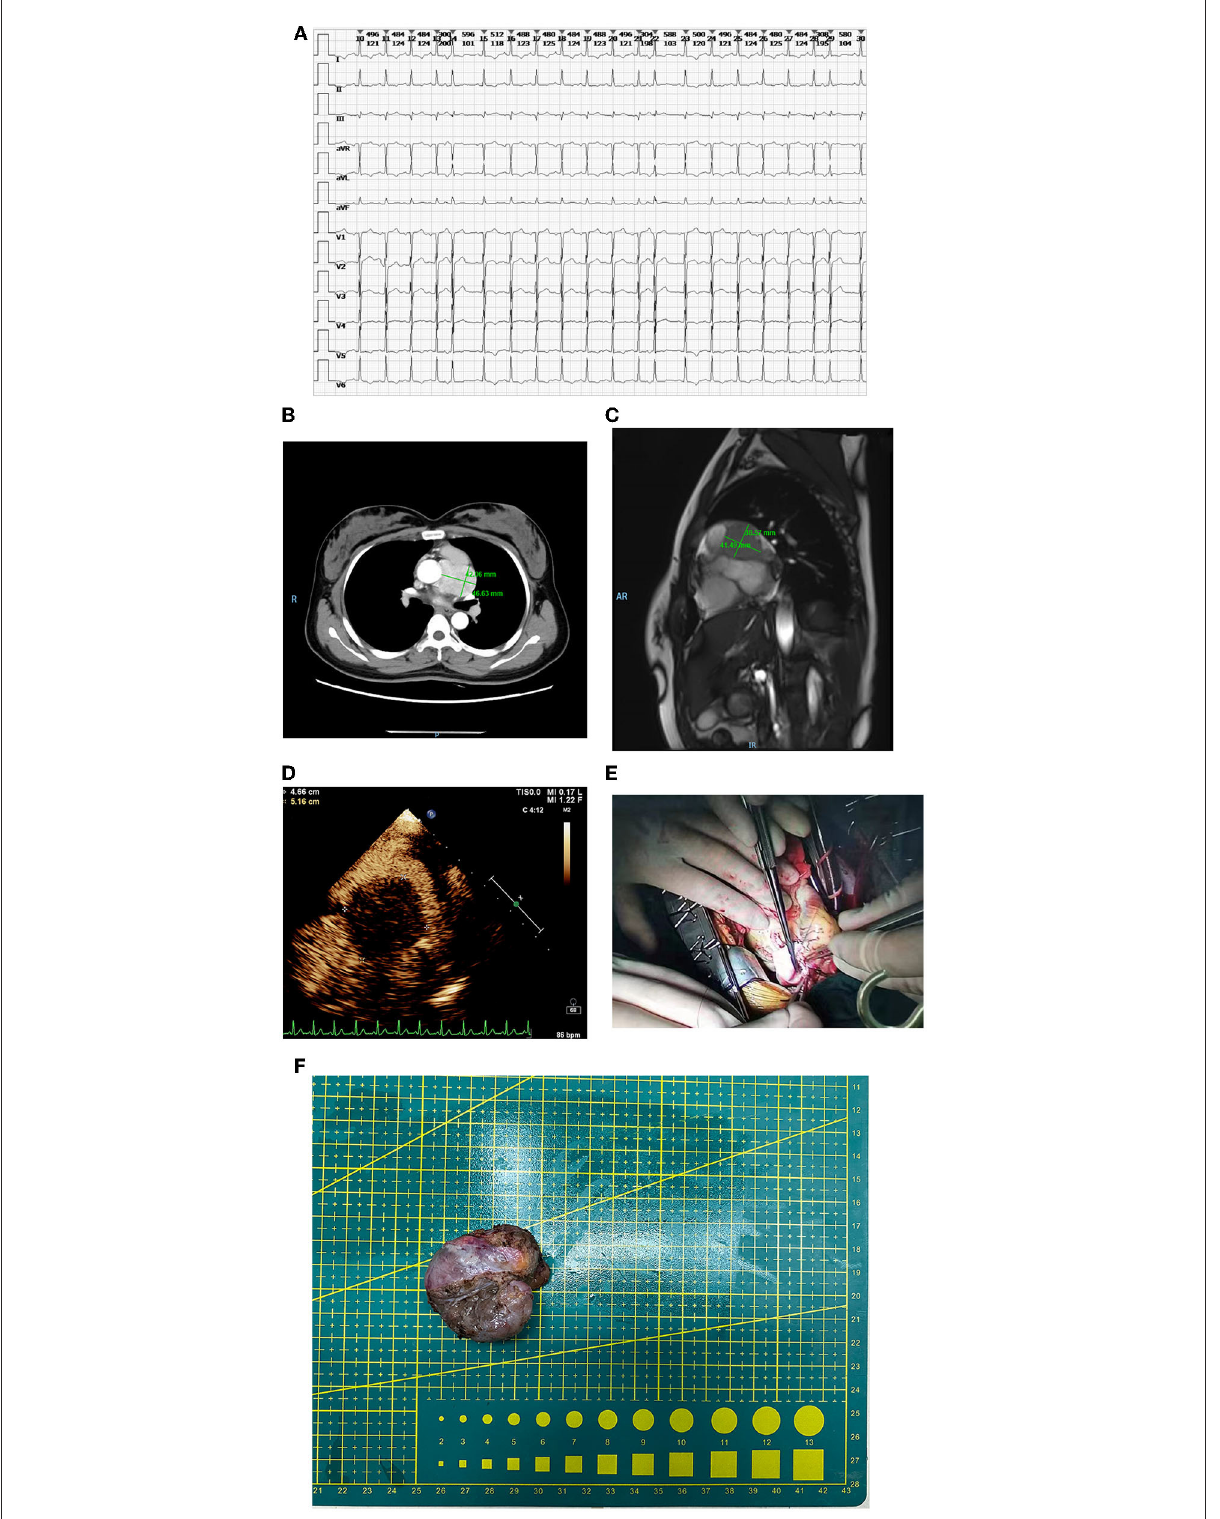
FIGURE1 (A) Tachycardia in electrocardiogram at admission. (B) The mass in the contrast-enhanced CT. The size was 46 × 42mm and serious adhesion between the aorta and the mass was found. Also, the involved left main coronary was observed. (C) The mass in the MRI. Both the root of the aorta and left main coronary were involved, however, the myocardium was free from involvement. (D) The mass in the echocardiography. The mass was fully perfused through mini-vascular circulation. (E) The repairing of the pulmonary artery. (F) The removed